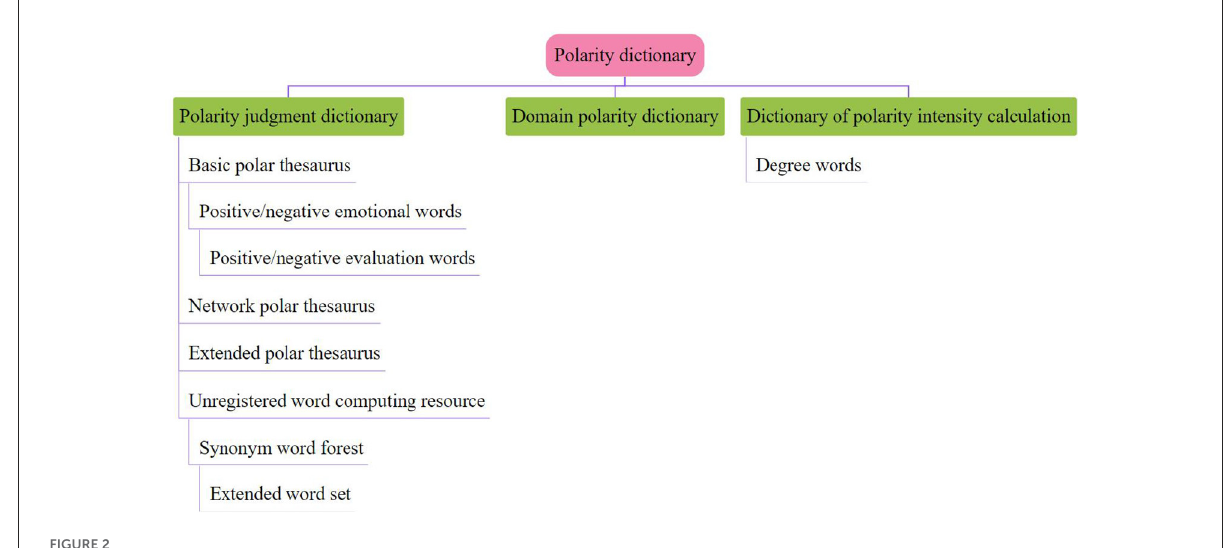
FIGURE2 Chinese polar dictionary structure.